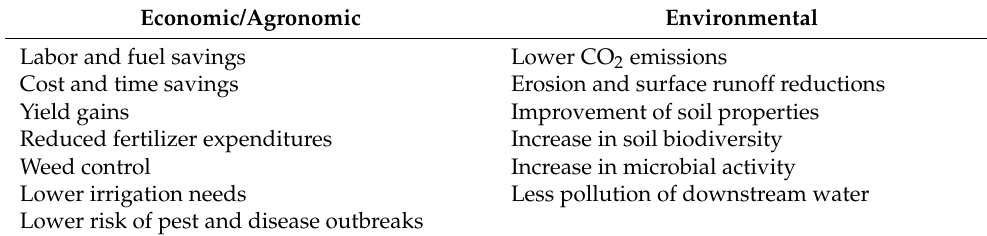
Table 1. Main economic/agronomic and environmental benefits generated by conservation agriculture. Economic/Agronomic